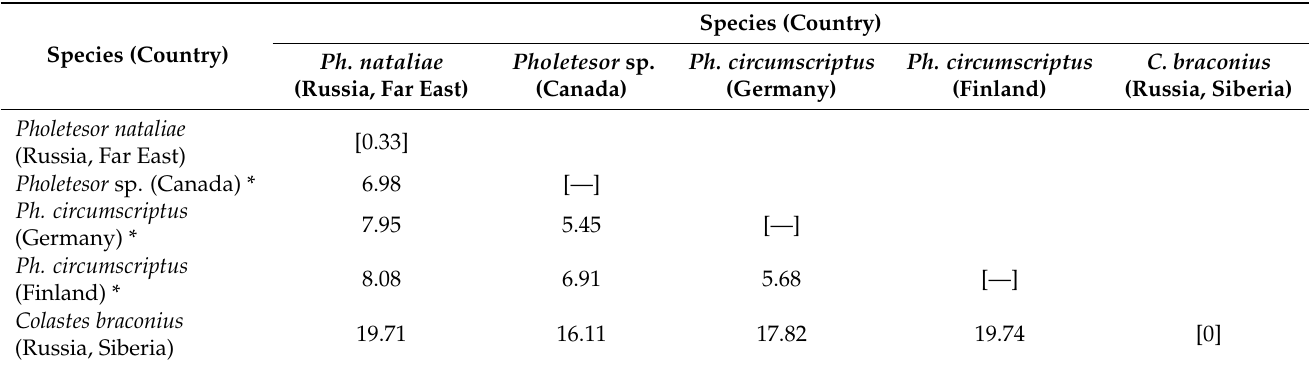
Table 3. Intra- and interspecific divergences in COI mtDNA gene among Braconidae parasitoid species of Phyllonorycter issikii , including three related species of Pholetesor from BOLD (indicated by *) for comparison. Minimal pairwise distances are given for each species pair; values in square brackets represent maximal intraspecific distances; [—] no data because a single specimen was